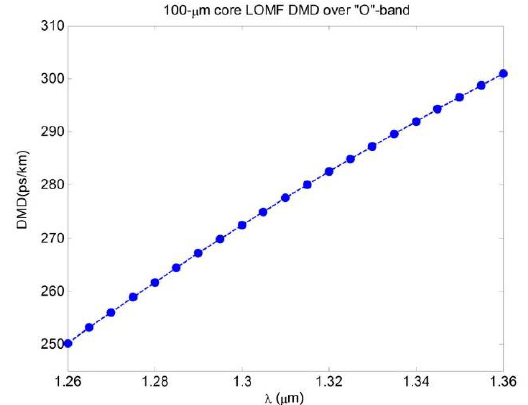
Figure 3. Computed spectral DMD ( λ ) curve over “O”-band with reference to the fundamental mode Figure 3. Computed spectral DMD (λ) curve over “O”-band with reference to the fundamental mode Figure 3. Computed spectral DMD (λ) curve over “O”-band with reference to the fundamental mode Figure 3. Computed spectral DMD (λ) curve over “O”-band with reference to the fundamental mode LP 01 LP 01 delay. LP 01 delay. LP 01 delay.